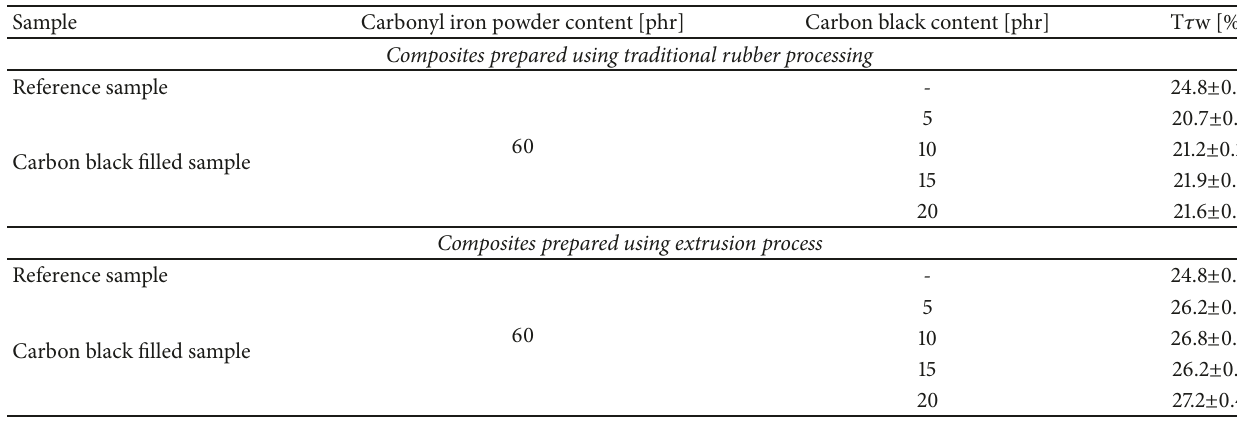
Table 4: Relative damping values of EOR vulcanizates obtained by various processing